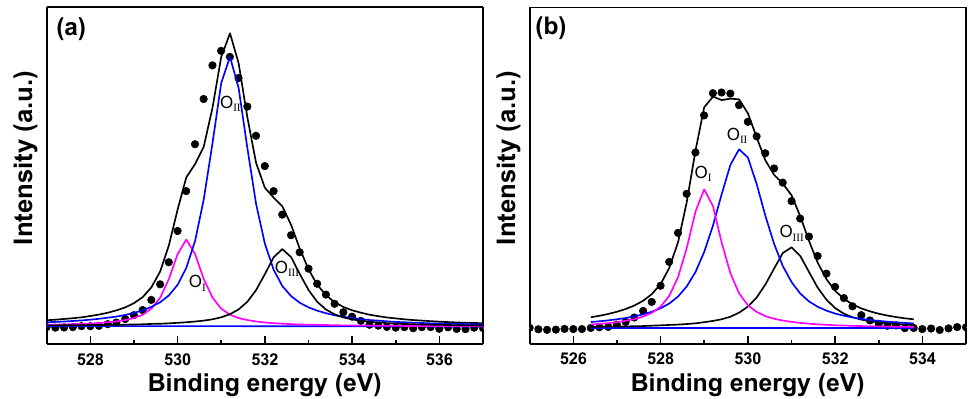
Figure 9. Binding energy spectra of O 1s peaks for GZO thin films on different substrates: ( a ) glass and ( b ) PI. Table 4. Comparison of area ratios of O I , O II , and O III peaks for GZO thin films on different substrates.